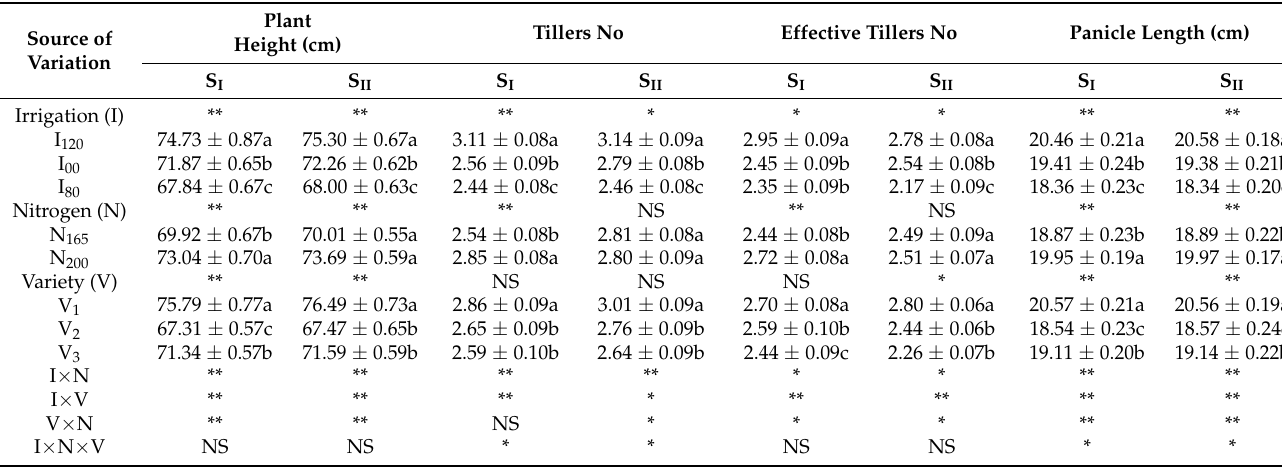
** and * refer to the significant difference at p ≤ 0.01 and p ≤ 0.05, respectively; and “ns” refers to no significant difference. Different letters next to mean values in each column indicate significant differences according to the LSD test ( p <